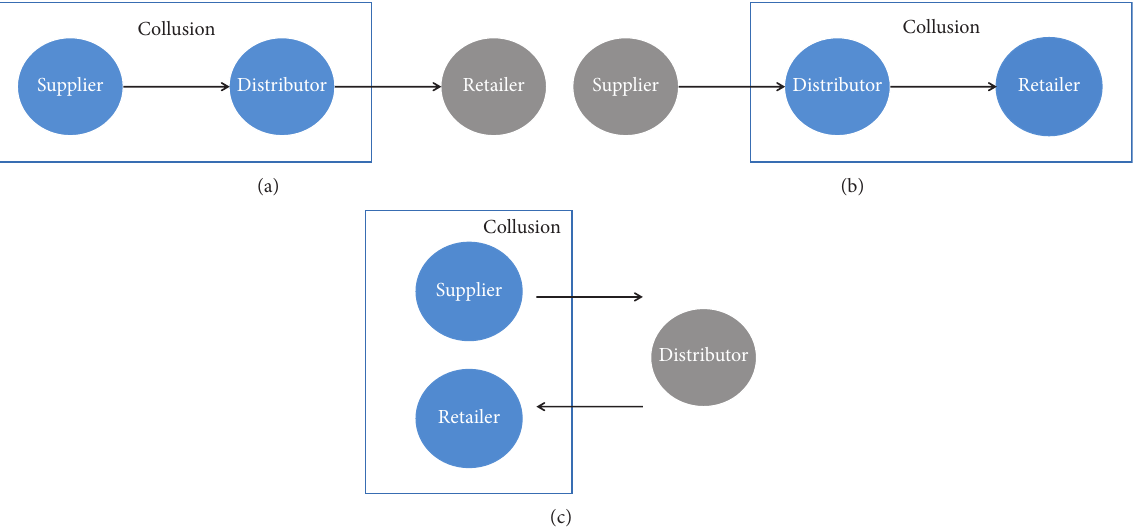
Figure 3: (a) Collusion between the supplier and distributor. (b) Collusion between the distributor and retailer. (c) Collusion between the supplier and